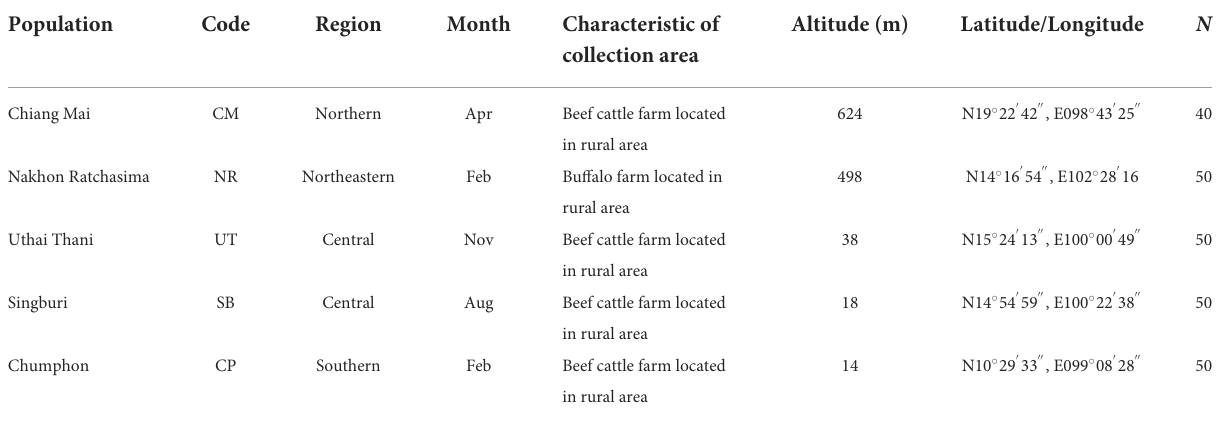
TABLE 1 Details of population, month, and number ( n ) of female Tabanus rubidus specimens used for the landmark-based geometric morphometric